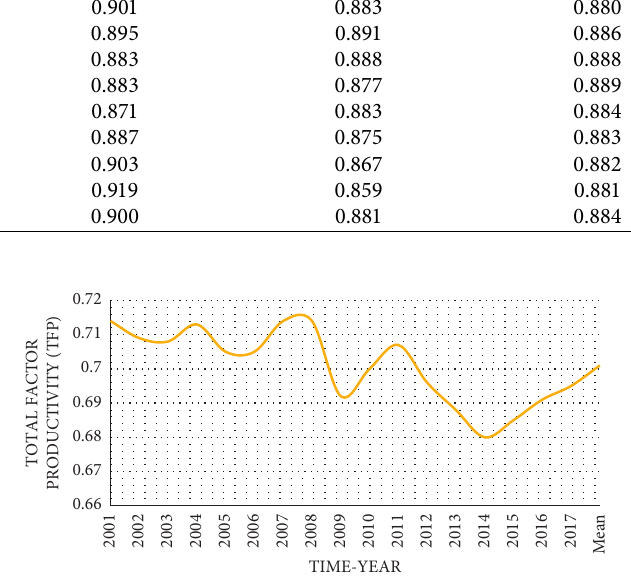
Figure 1: 2001–2017 national average total factor productivity